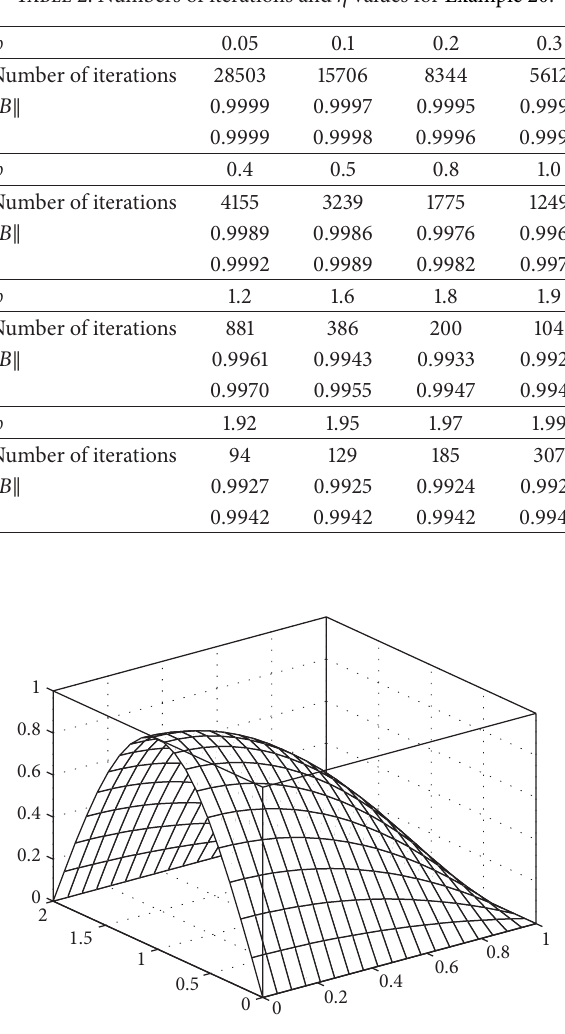
Figure 3: The approximate solution for Example 20.